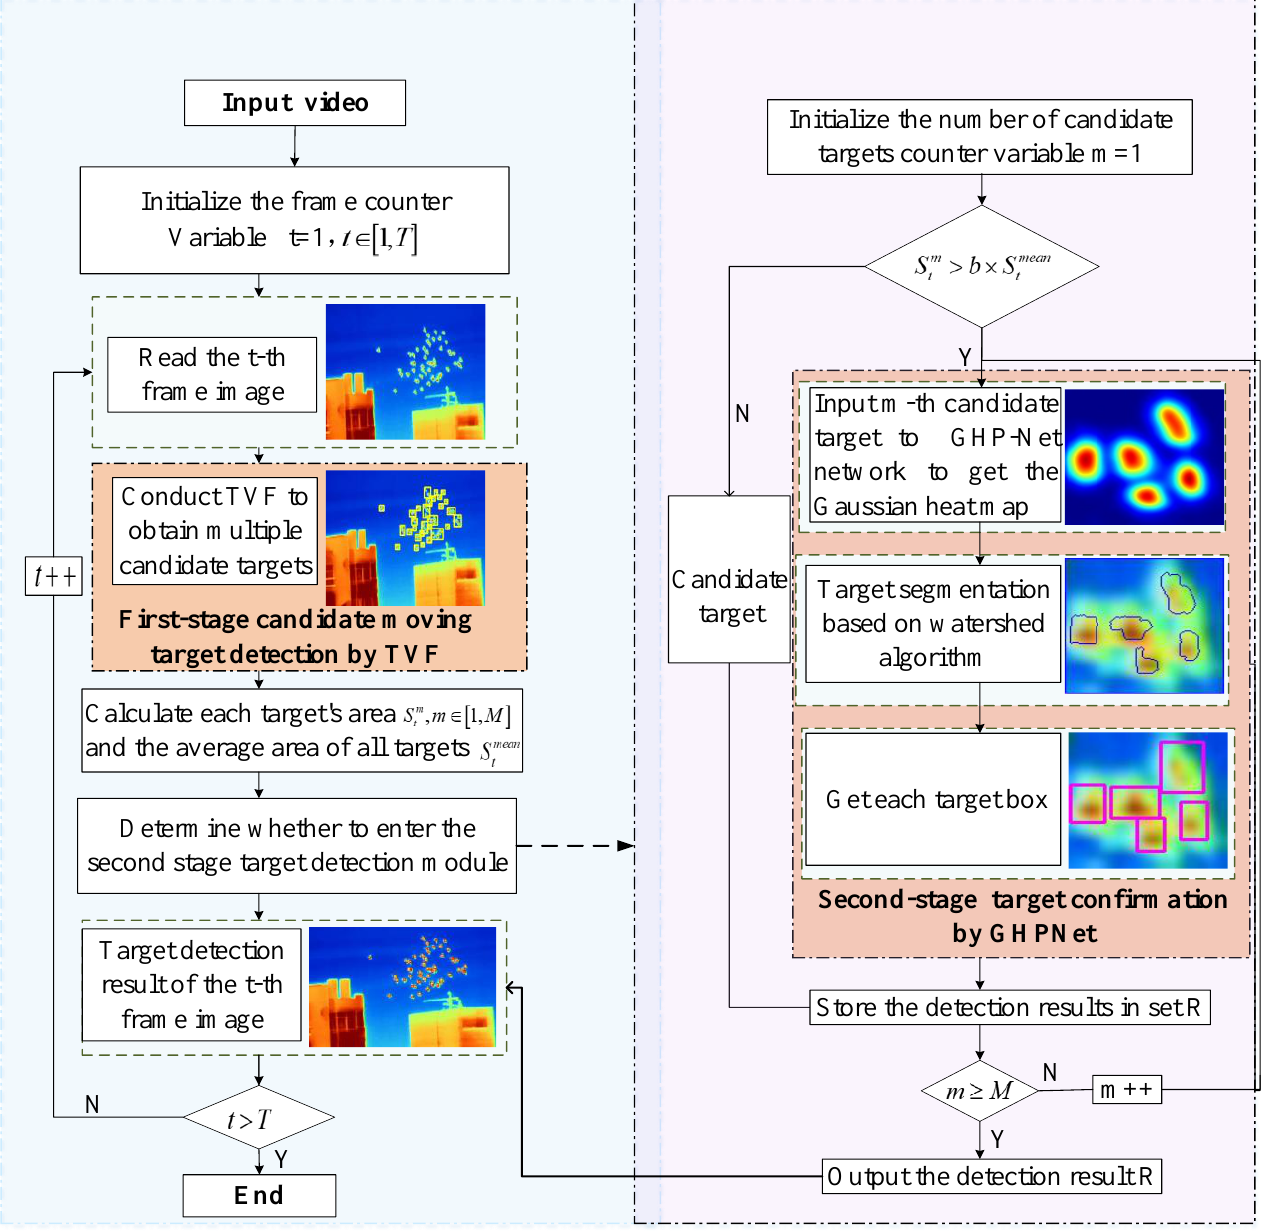
Figure 1. The flow chart of the proposed bird detection algorithm.